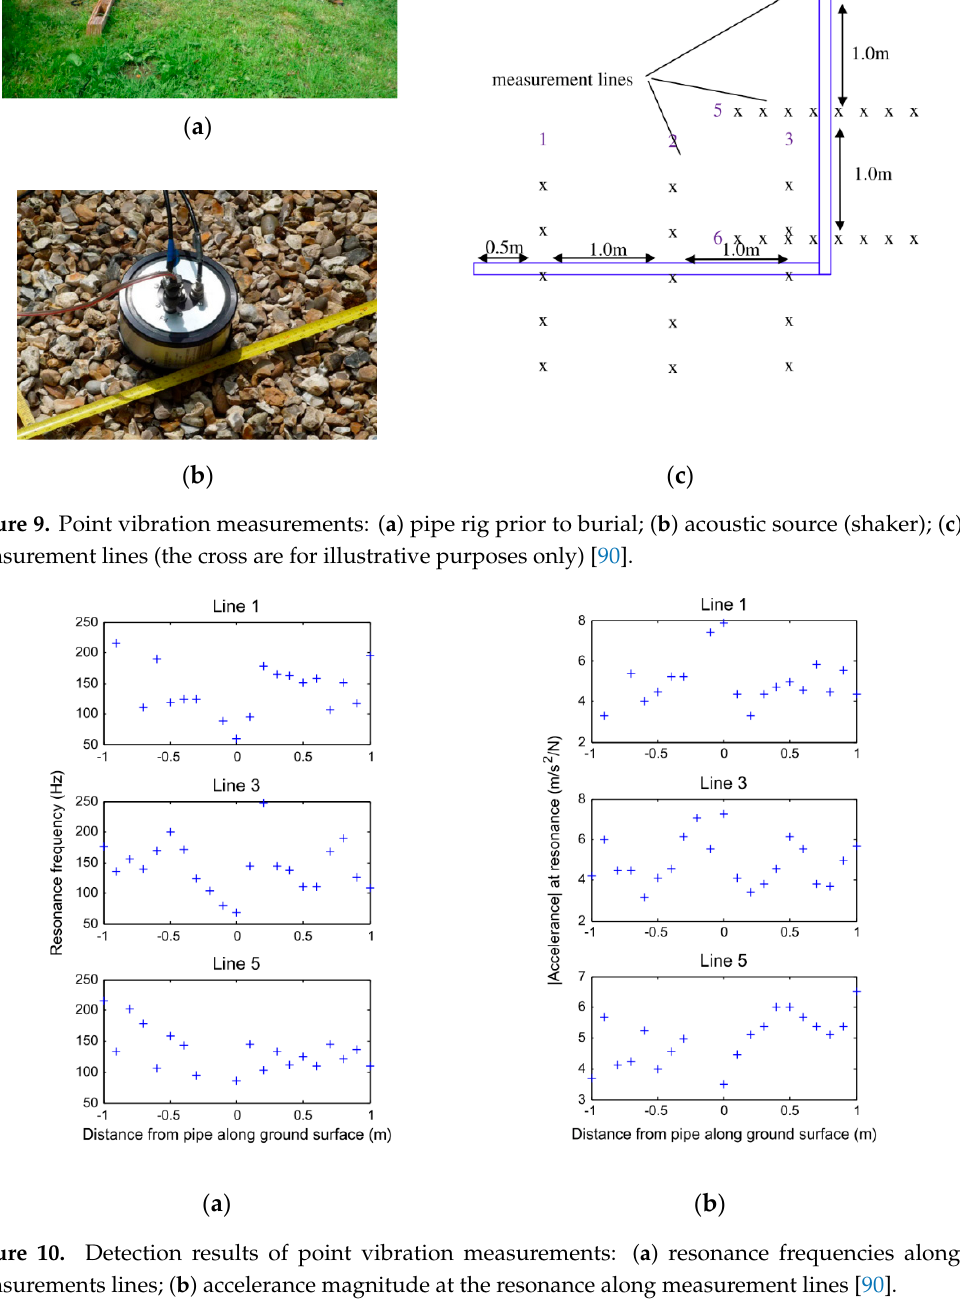
Figure 10. Detection results of point vibration measurements: ( a ) resonance frequencies along measurements lines; ( b ) accelerance magnitude at the resonance along measurement lines [90].